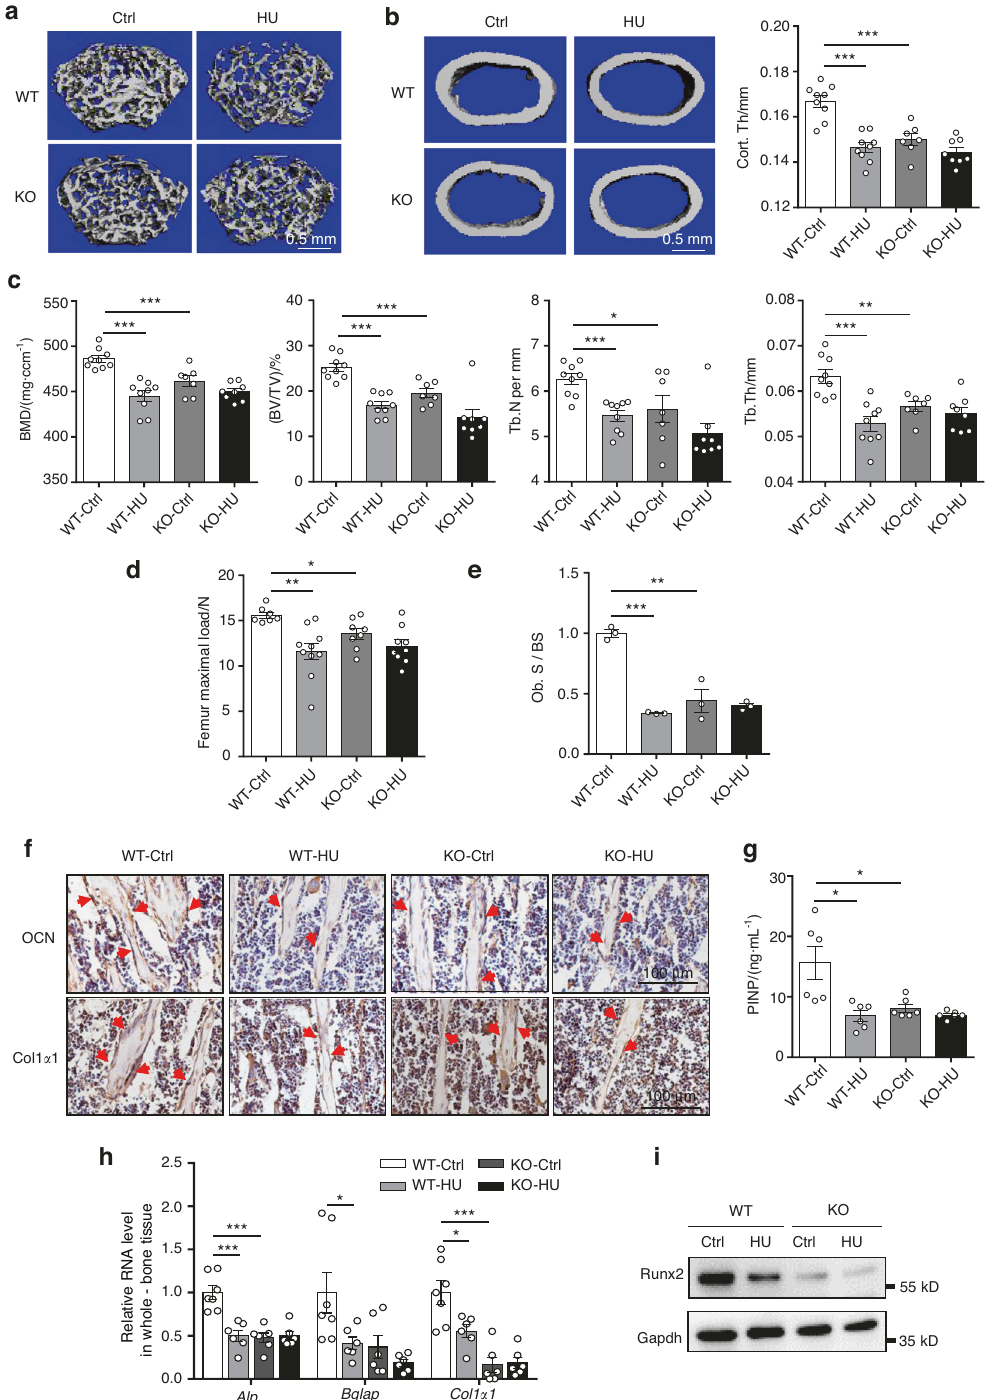
Fig. 7 Unloading-induced bone loss was blunted in the Neat1 knockout mice. a , b Representative 3D μ -CT images showing trabecular and cortical bones from distal femurs isolated from 15-week-old WT and Neat1 -KO mice of the indicated groups. Scale bars, 0.5 mm. Cortical bone thickness of distal femurs from the control and HU mice was analyzed. n = 7 – 9 in each group. c Quantitative µ-CT analysis of BMD, BV/TV, Tb.N and Tb.Th from 15-week-old WT and Neat1 -KO mice in the indicated groups. n = 7 – 9 in each group. d Femur maximal load determined by three-point bending of 15-week-old WT and Neat1 -KO mice of the indicated groups. n = 7 – 10 in each group. e Histomorphometric analysis of osteoblast surface per bone surface in the WT and Neat1 -KO mice with or without hindlimb unloading. n = 3 in each group. f Immunohistochemical staining of OCN and Col1 α 1 in tibial sections from 15-week-old Neat1 -KO mice and WT mice with or without hindlimb unloading. Scale bars, 100 μ m. g ELISAs of serum PINP (ng·mL − 1 ) in the control and Neat1 -KO mice with or without hindlimb unloading. n = 6 in each group. h The expression of osteogenic genes in whole-bone tissue from the WT and Neat1 -KO mice with or without hindlimb unloading. n = 6 or 7 in each group. i Immunoblot analysis of Runx2 protein levels in whole-bone tissue from the WT and Neat1 -KO mice with or without hindlimb unloading. Representative results of three independent experiments are shown. * P < 0.05, ** P < 0.01, *** P <